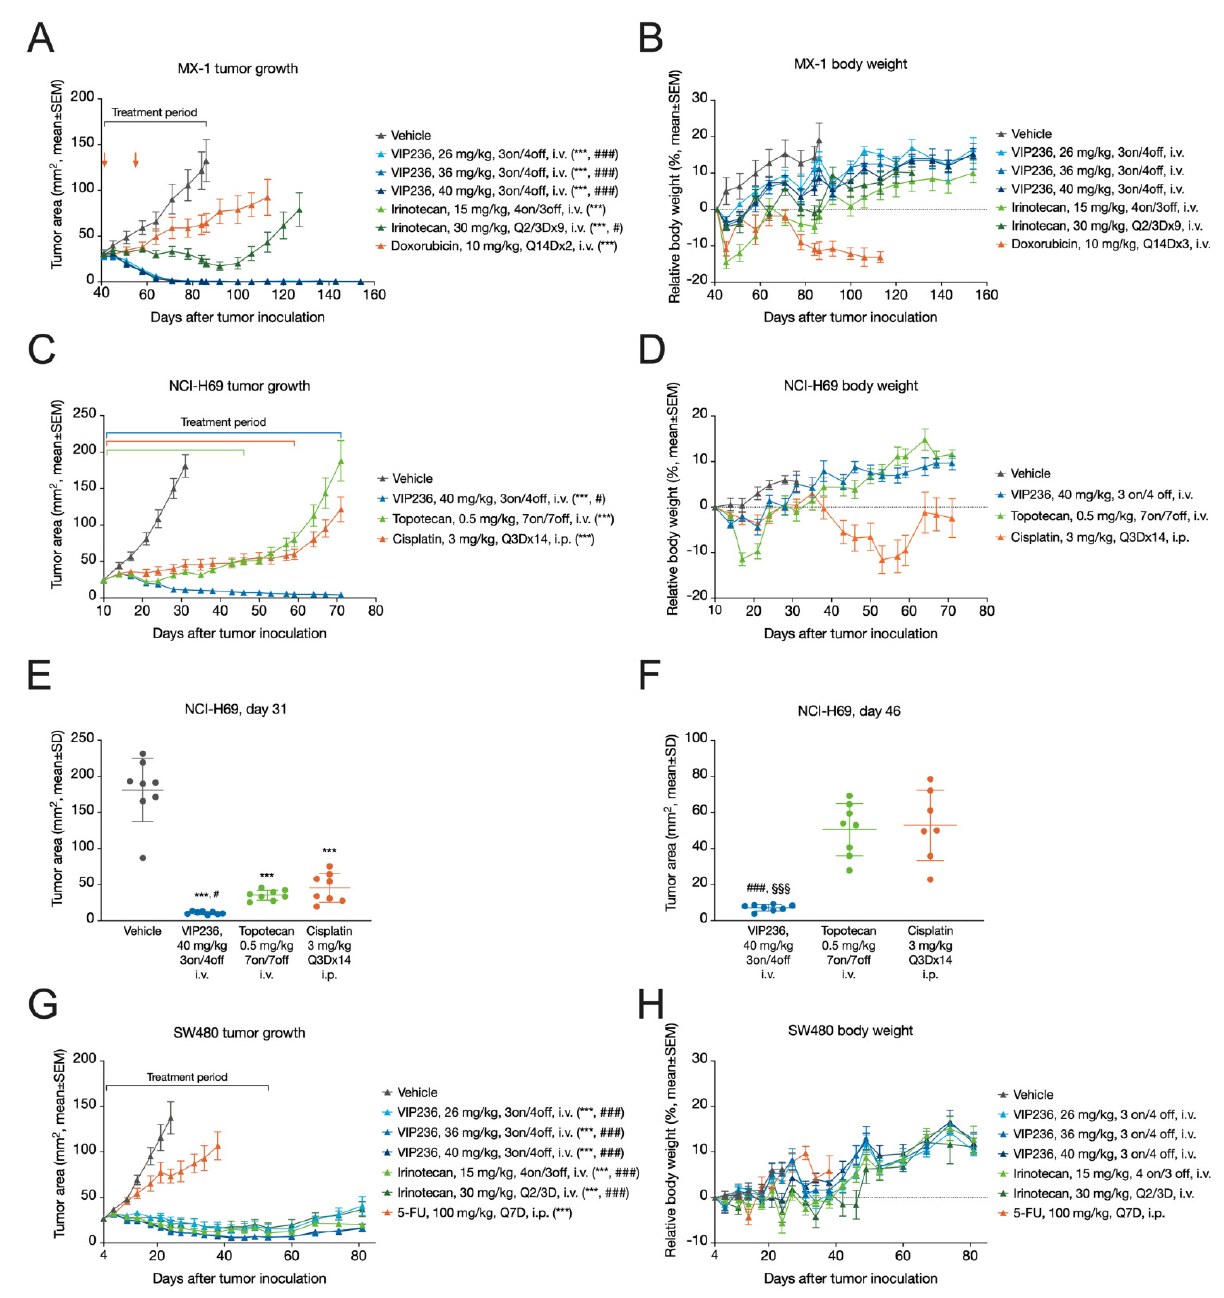
Figure 4. Antitumor efficacy of VIP236 and reference compounds in mouse xenograft models. ( A ) Growth curves of MX-1 TNBC tumors in female NMRI nu/nu mice ( n = 8/group) treated with vehicle, VIP236 (23, 36, or 40 mg/kg, 3 on/4 off, i.v.), irinotecan (15 mg/kg, 4 on/3 off, i.v. or 30 mg/kg, Q2/3Dx9, i.v.), or doxorubicin (10 mg/kg, Q14Dx2, i.v.). ( B ) Relative body weight change of the MX-1 tumor-bearing mice treated as described in ( A ). ( C ) Growth curves of NCI-H69 SCLC tumors in female NMRI nu/nu mice ( n = 8/group) treated with vehicle, VIP236 (40 mg/kg, 3 on/4 off, i.v.), topotecan (0.5 mg/kg, 7 on/7 off, i.v.), or cisplatin (3 mg/kg, Q3Dx14, i.p.). ( D ) Relative body weight change of the NCI-H69 tumor-bearing mice treated as described in ( C ). ( E ) Areas of the NCI- H69 tumors described in ( C ) on the last day of the vehicle group (Day 31). ( F ) Areas of the NCI-H69 tumors described in ( C ) on the last day of the topotecan treatment group (Day 46). ( G ) Growth curves of SW480 tumors in female NMRI nu/nu mice ( n = 8/group) treated with vehicle, VIP236 (23, 36, or 40 mg/kg, 3 on/4 off, i.v.), irinotecan (15 mg/kg, 4 on/3 off, i.v.; or 30 mg/kg, Q2/3Dx9, i.v.), or 5-FU (100 mg/kg, Q7D, i.p.). ( H ) Relative body weight change of the SW480 tumor-bearing mice treated